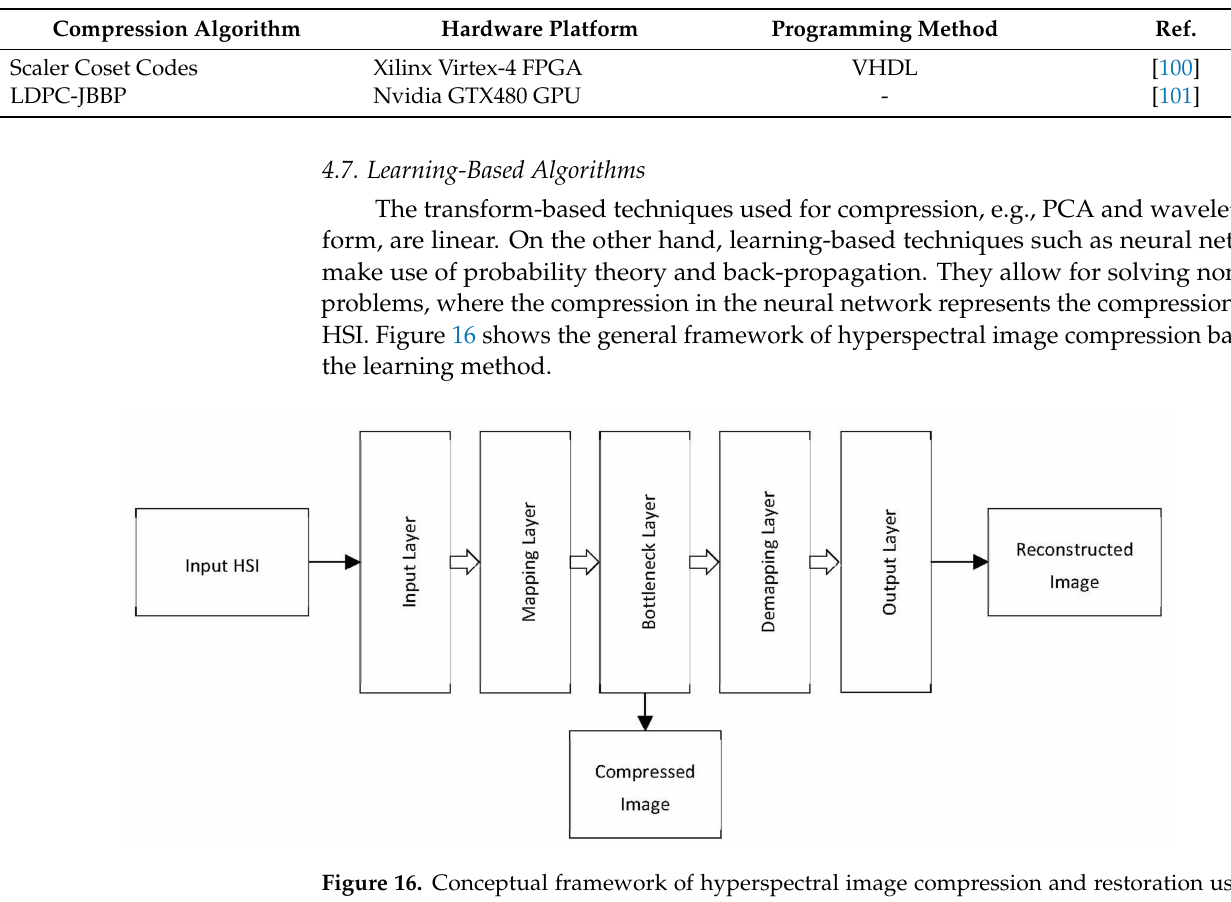
Table 8. List of studies on DSC-based compression systems of hyperspectral images and their hardware platforms.